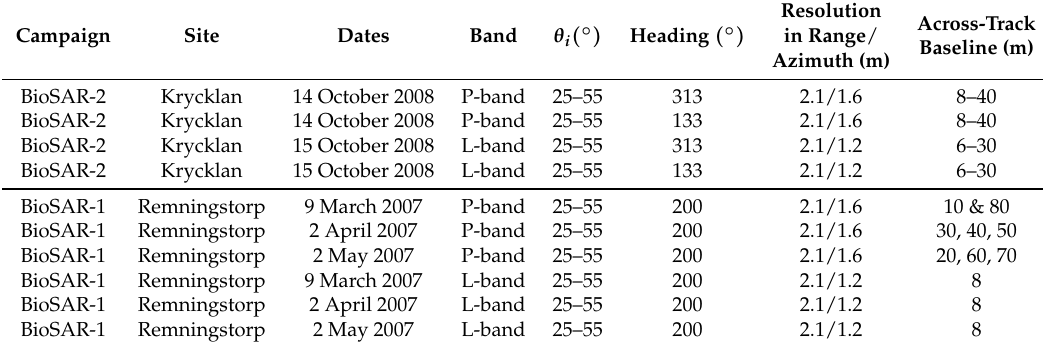
Table 1. Overview of used SAR acquisitions (after [40,41]; θ i means incidence angle).